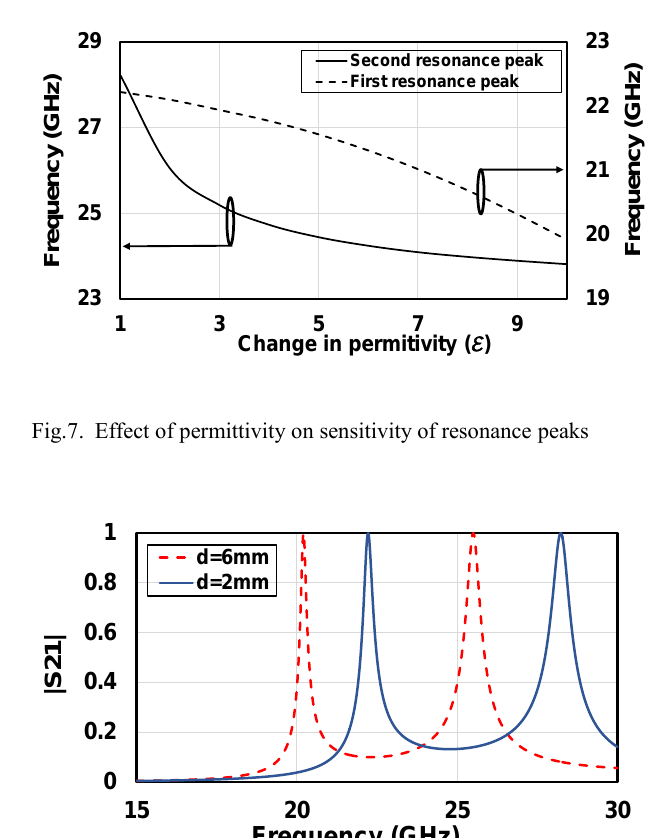
Fig.6. Effect of permittivity change from 4-10, on magnitude of transmission coefficient